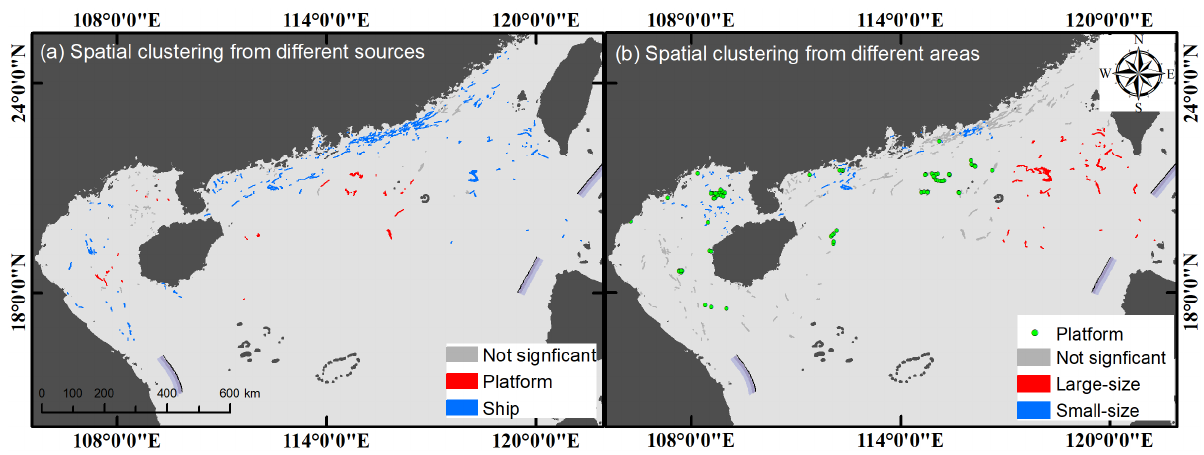
Figure 13. The spatial cluster of oil slicks: ( a ) from different sources: and ( b ) from different areas determined by the Gi * method.